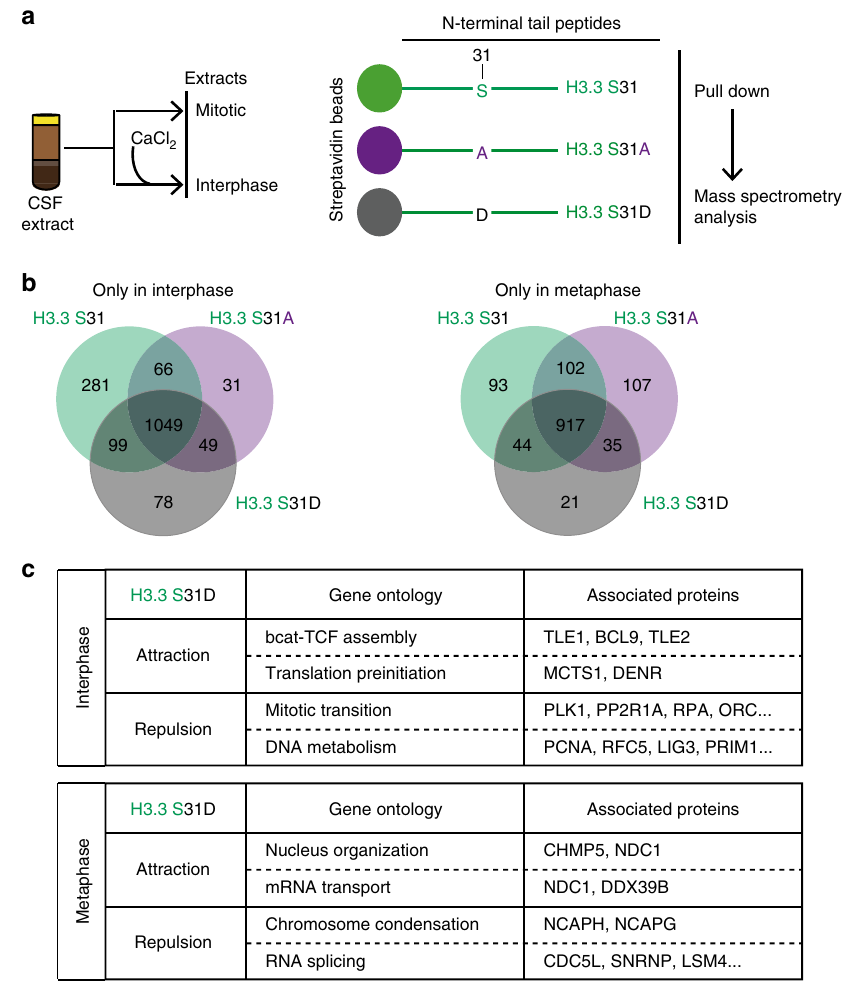
Fig. 6 Mass spectrometry of H3.3 peptides in interphase and mitotic extracts reveals distinct protein associations. a Peptide pull-down strategy. Biotinylated peptides corresponding to H3 N-terminal tails are incubated in mitotic and interphase Xenopus egg extracts before pulldown, to identify interactors by proteomics mass spectrometry analysis performed from three replicates. b Venn diagrams of proteins identi fi ed by mass spectrometry analyses from H3 N-terminal biotinylated peptides in Xenopus egg extracts. Binding partners are selected with at least three peptides in “ best analysis ” either in interphase or mitotic extracts, speci fi cally. c Summary of Gene Ontology analysis. Attraction refers to factors pulled down with the H3.3 S31D mutant. Repulsion refers to factors that are not pulled down with the H3.3 S31D mutant. Highlights from the top p -value ranked Gene Ontology molecular processes for attracted and repulsed factors are displayed with a selection of associated proteins. See Supplementary Fig. 6 for all top 5 p -value ranked molecular processes from Gene Ontology analysis for each condition obtained with the Enrichr tool 106